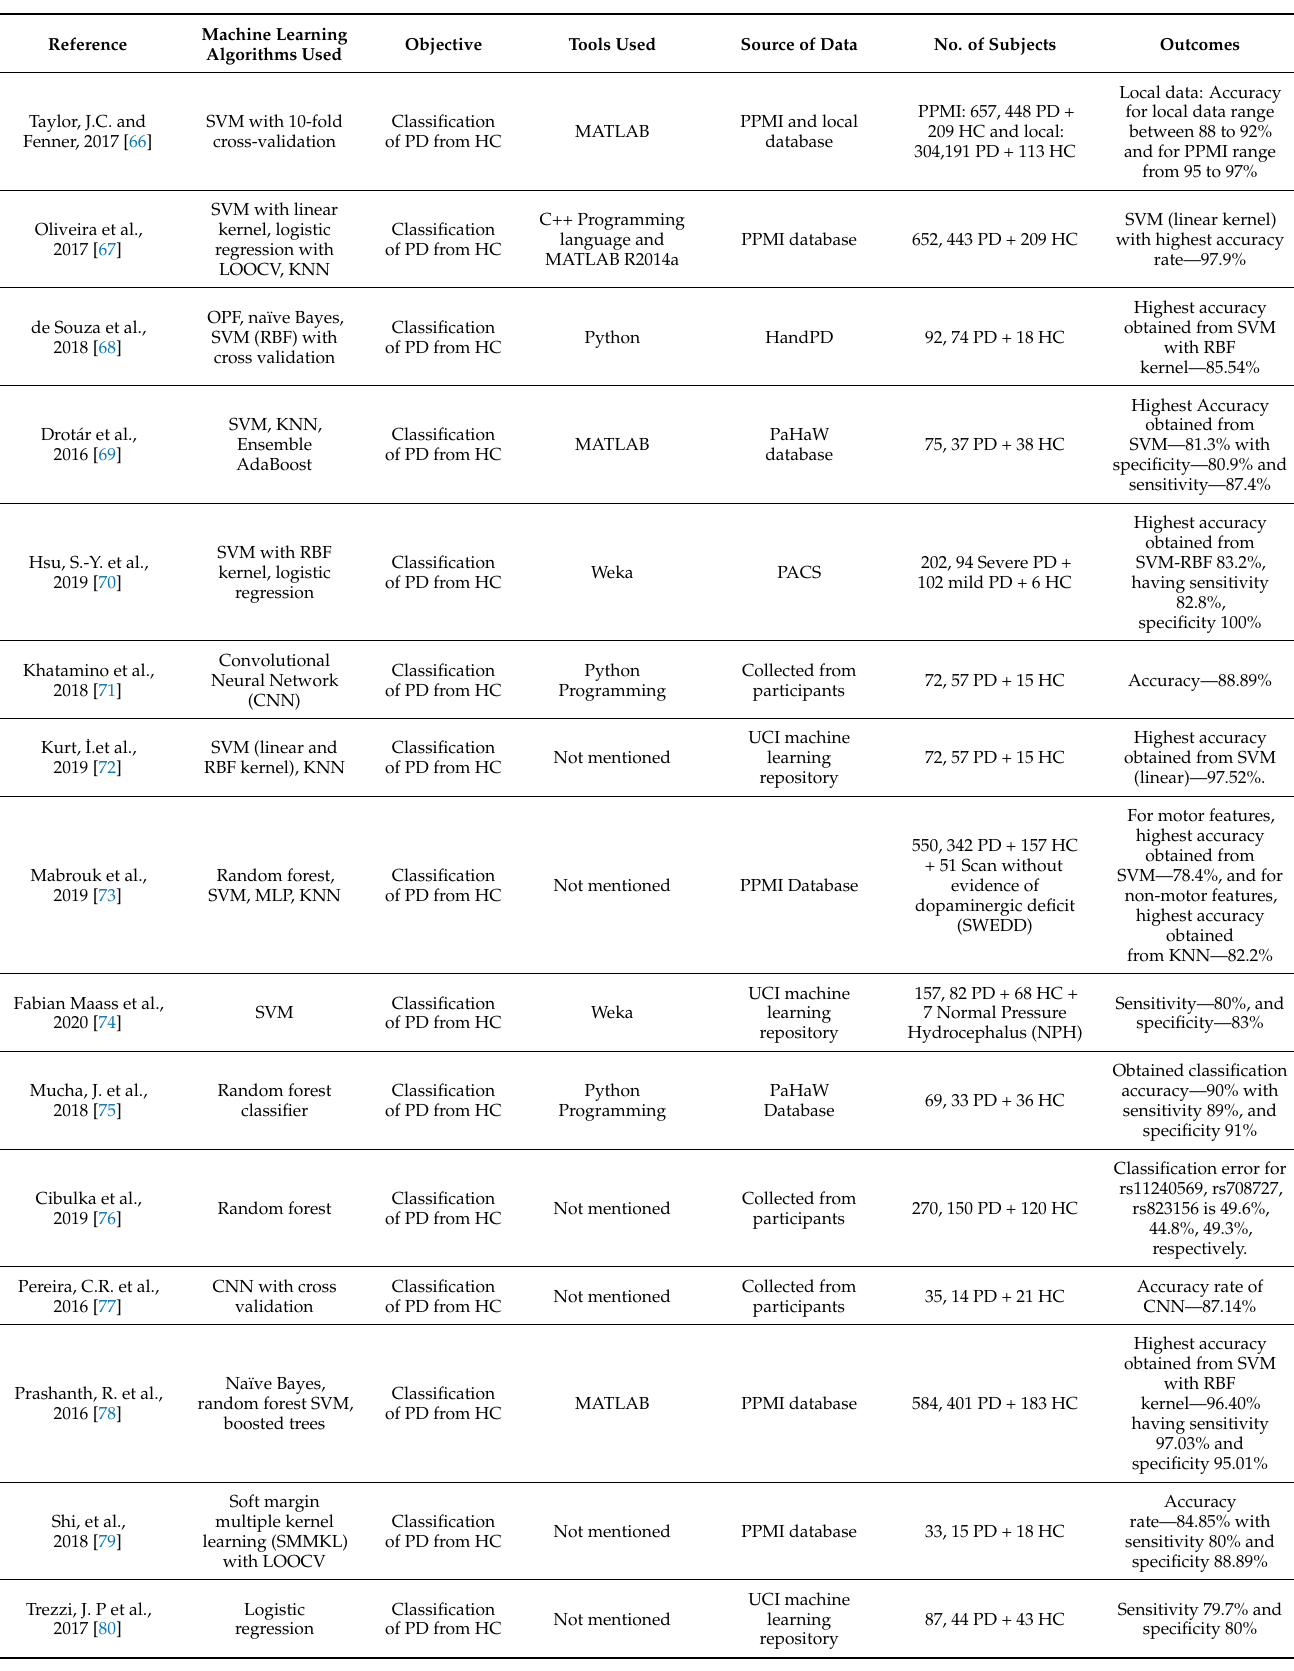
Table 2. Comparative studies of machine learning approaches in handwritten patterns to diagnose